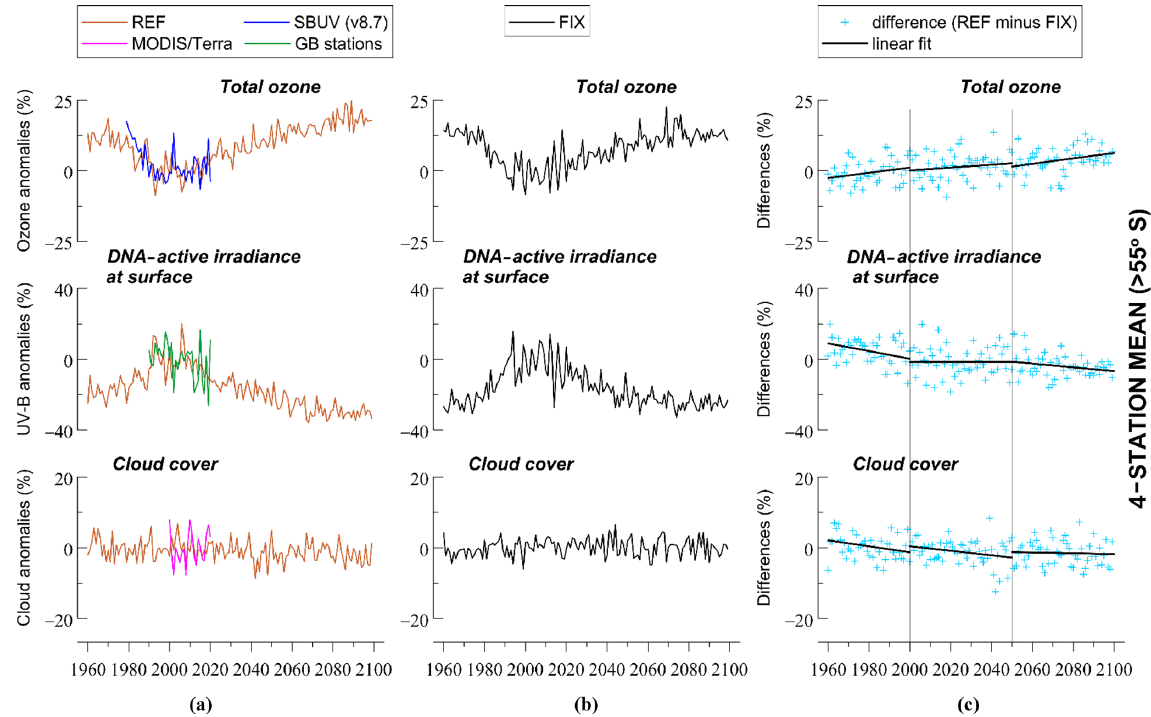
Figure 6. Same as Fig. 4 but for four UV stations in the southern high latitudes ( > 55 ◦ S). The y axes in (a) and (b) show averages of monthly de-seasonalized anomalies from September to March.